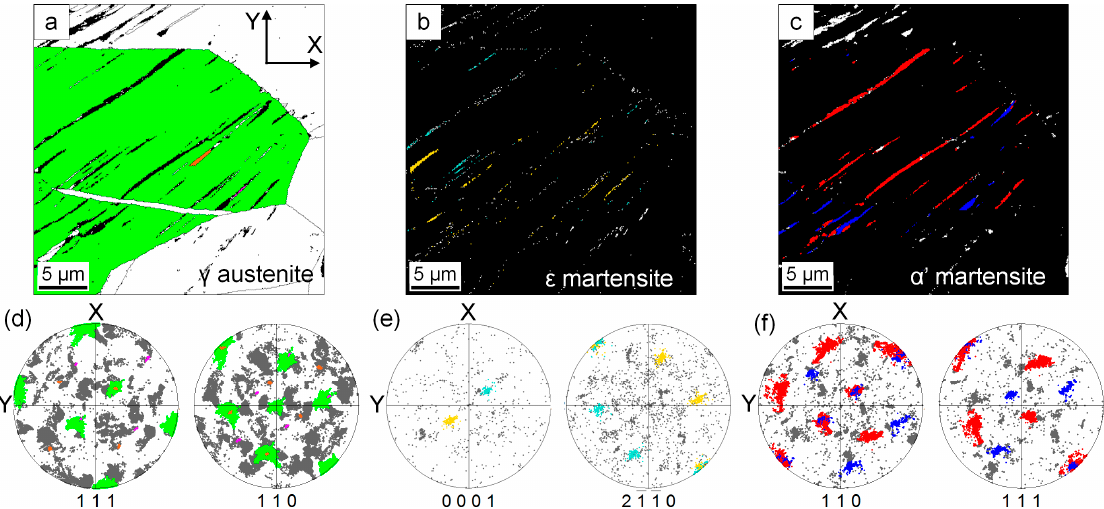
Figure 6. ( a – c ) Phase partition maps of the electron backscattered diffraction (EBSD) measurement results of the deformed sample up to a true strain of 0.11. The white and colored points correspond to the selected phase. ( d – f ) Discrete pole figures of the corresponding phase maps. The same color highlighting is applied as in the maps; ( a , d ) γ austenite, ( b , e ) ε martensite, and ( c , f ) α ’ martensite.